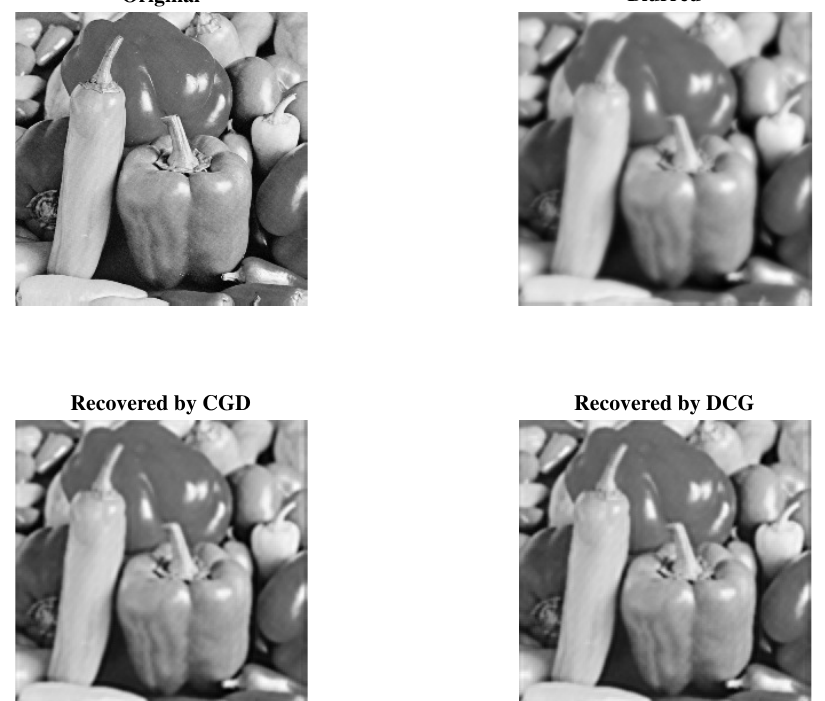
Figure 8. The original image ( top left ), the blurred image ( top right ), the restored image by CGD ( bottom left ) with SNR = 21.50, SSIM = 0.84 and by DCG ( bottom right ) with SNR = 21.81, SSIM =